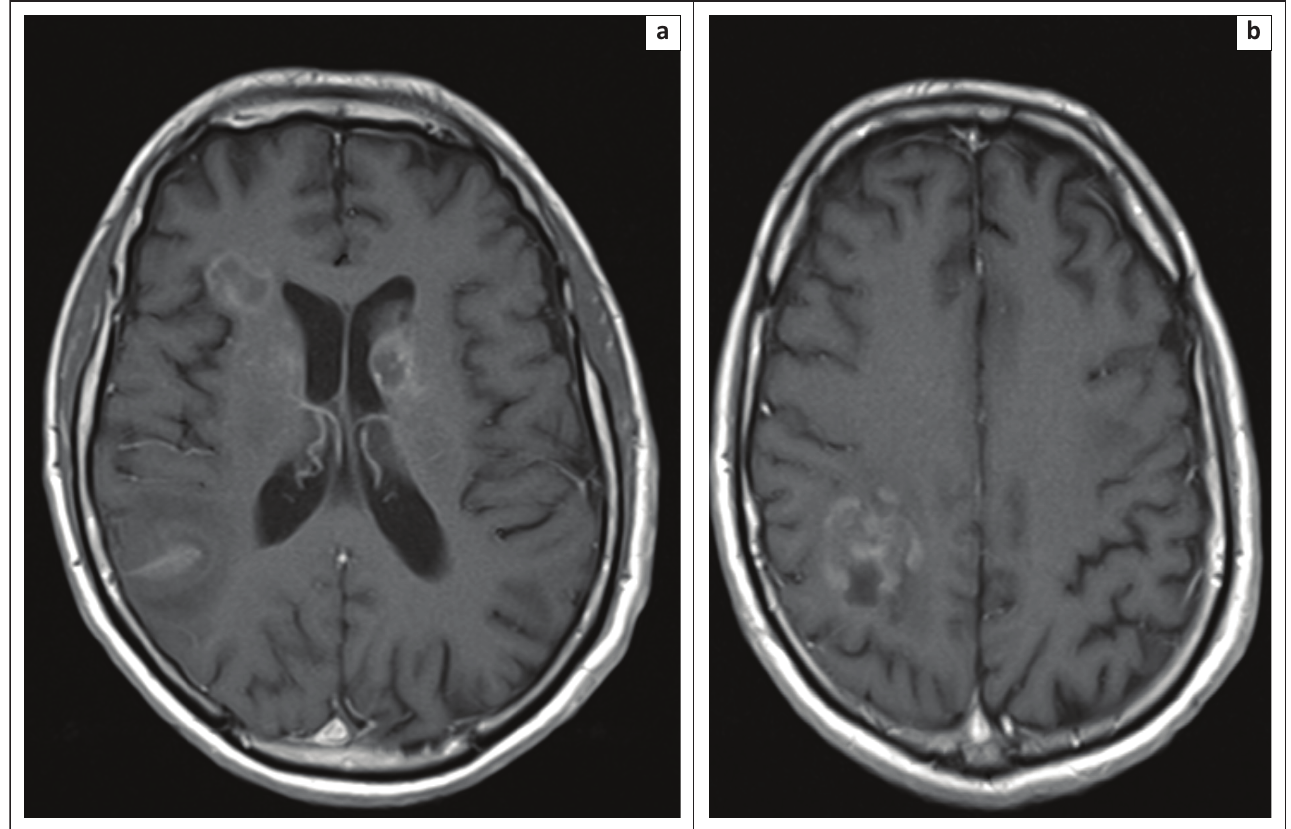
FIGURE 4: Post-gadolinium contrast enhanced T1 axial slices from MR brain performed 2 months following the initial clinical presentation. The patient had been commenced on MATRix chemotherapy. Multiple peripherally enhancing parenchymal (b) and sub-ependymal lesions (a) are demonstrated with a significant improvement in the size of all lesions since the last examination. New high signal on T1 imaging (not demonstrated) may represent post-treatment interval